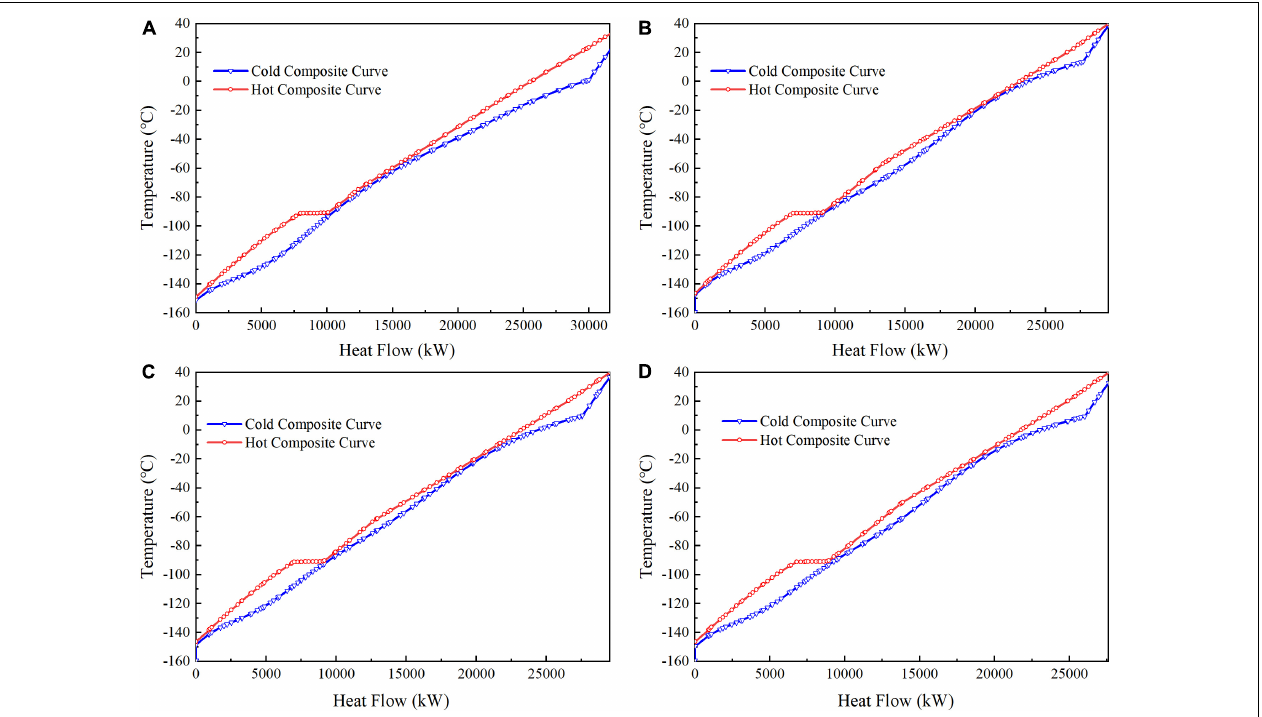
FIGURE 5 | Temperature-heat flow diagram of the hot and cold composite curves (THCC) of four cases: (A) base case; (B) modified case 1; (C) modified case 2; (D) modified case 3.